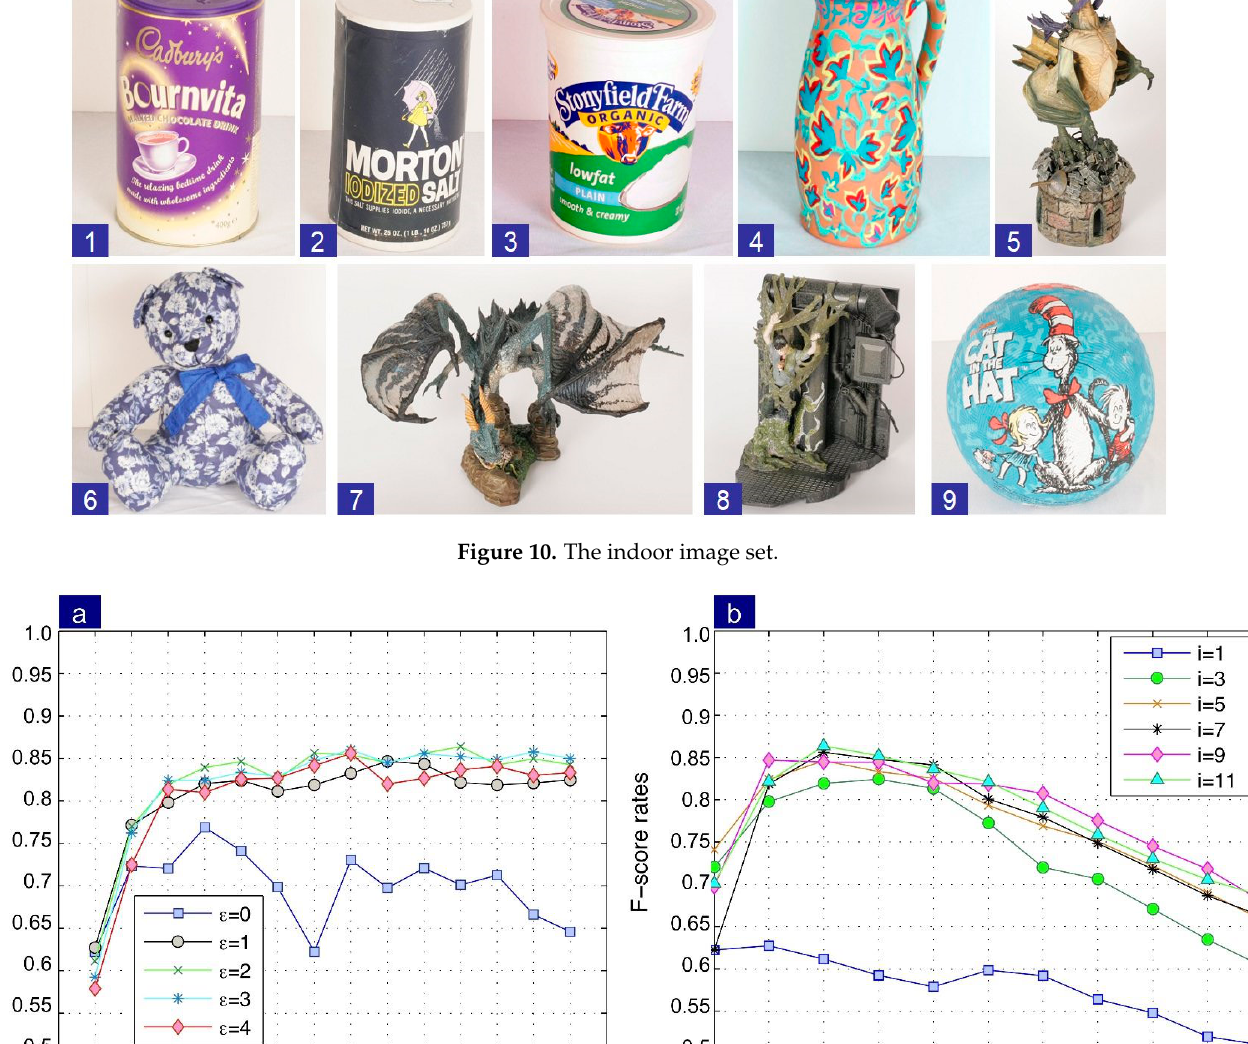
14 of 21 Figure 9. Average performance obtained in the outdoor image set: ( a ) The effect of ε in the method’s performance. ( b ) Influence of parameter i on performance as a function of 𝜀 . 4.2. Indoor Image Set